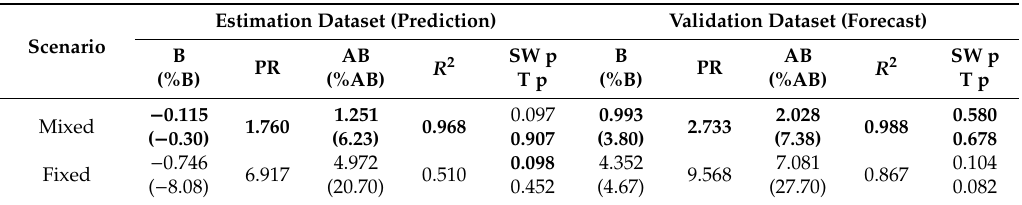
Table 4. Statistical indexes and p -values of the Shapiro-Wilk (SW p ) and Student (T p ) tests for the basal area (m 2 ha − 1 ) Equation (20)